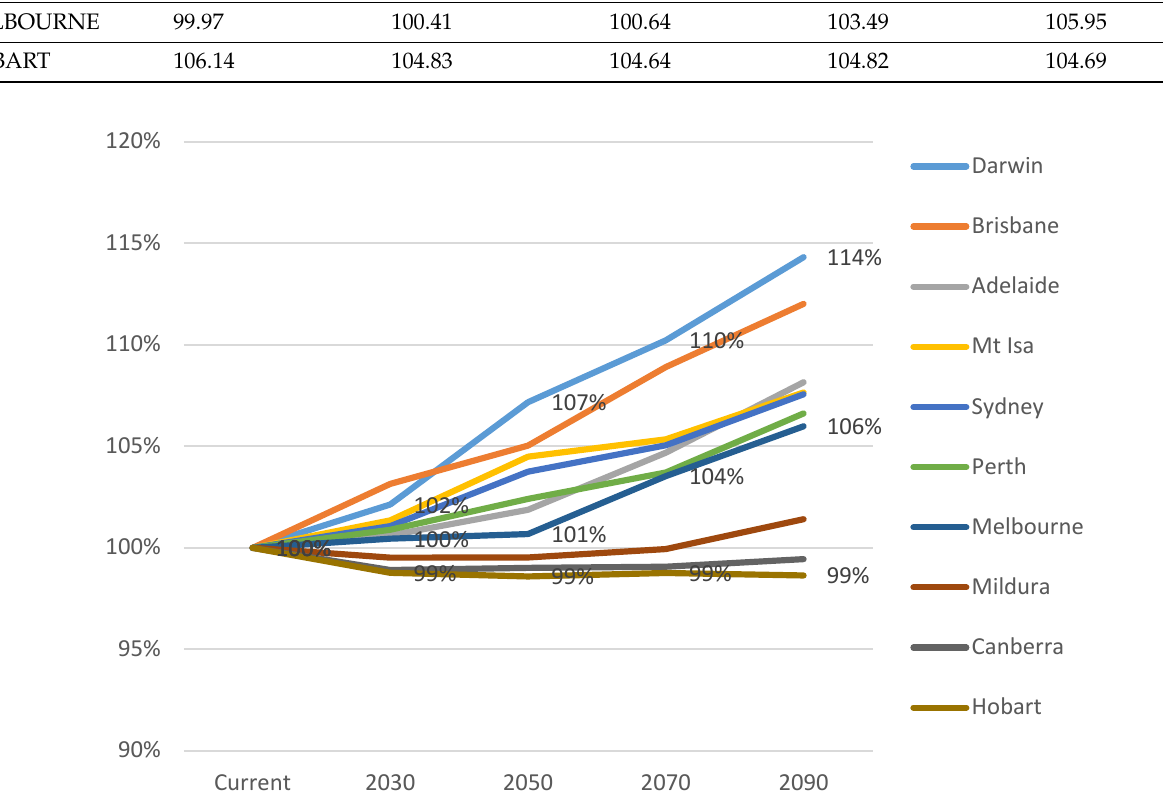
Figure 13. Large hospital’s yearly HVAC energy use benchmarking.